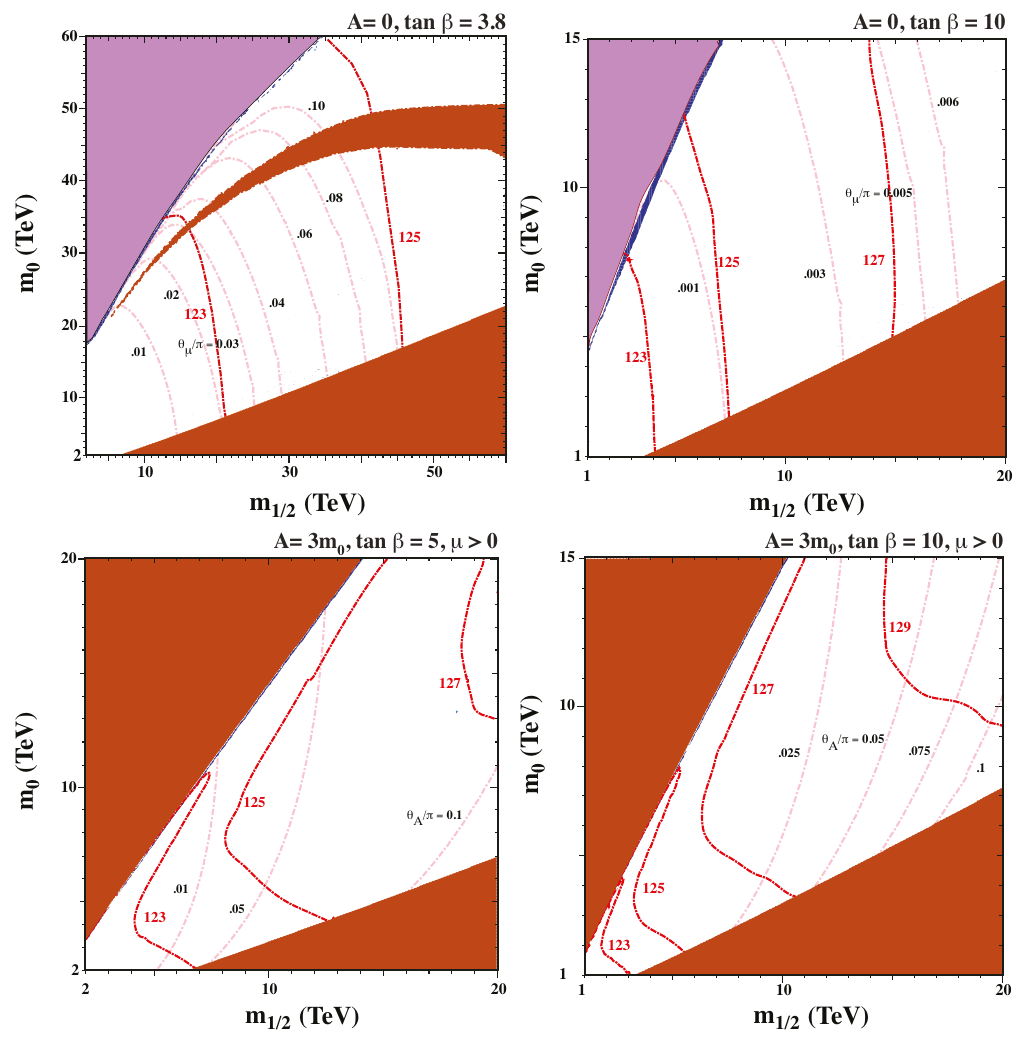
Figure 3 . As in figure 2 using the neutron EDM assuming that the current neutron EDM limit is multiplied by 10 − 3 . Limits on θ µ (upper panels) and θ A (lower panels) are shown by pink dot dashed